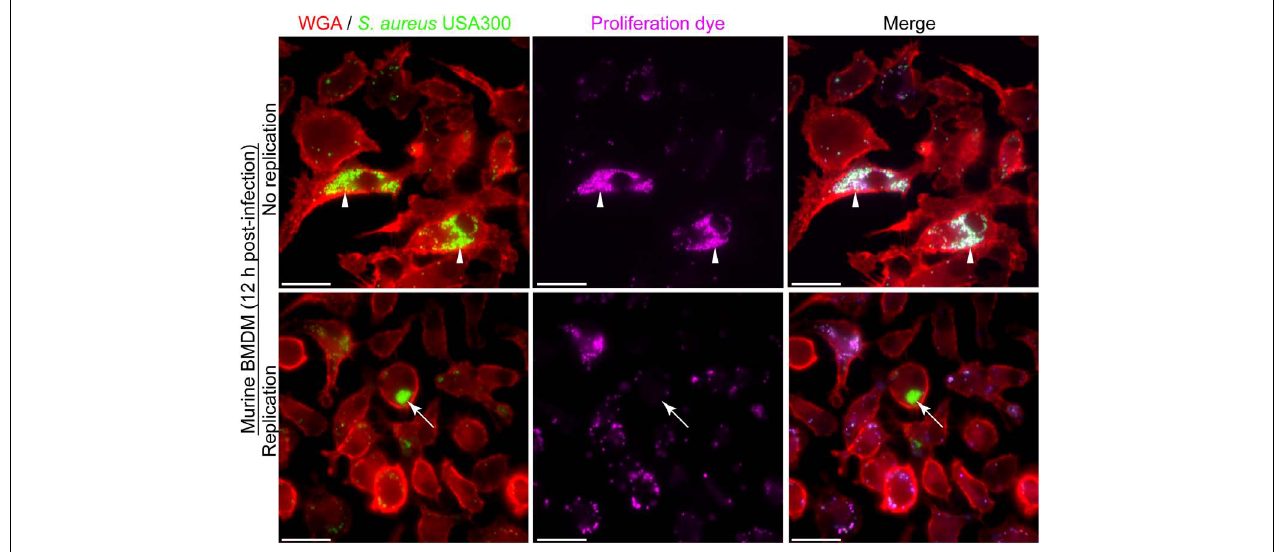
FIGURE 2 | The presence of large populations of intracellular bacteria does not accurately demonstrate the presence of replicating bacteria. The representative images are of TMR-WGA labeled murine bone-marrow-derived macrophages (BMDM, in red) that were incubated with GFP-expressing S. aureus USA300 (in green) labeled with eFluor TM -670 (pseudo-colored pink) at an MOI of 10. Images were acquired at 12 h post-infection. Arrow heads in the top panels indicate macrophages containing many S. aureus cocci, however, these bacteria are eFluor TM -670 positive and therefore have not replicated. White arrows point to GFP-positive yet eFluor TM -670 negative S. aureus indicating these bacteria have indeed replicated intracellularly. These data represent observations made from more than six independent experiments. Scale bar is ∼ 10 µ m.